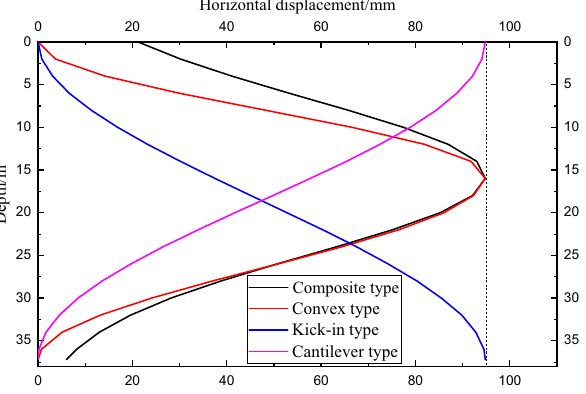
Figure 7. Deformation curves of sidewall under different deformation modes.